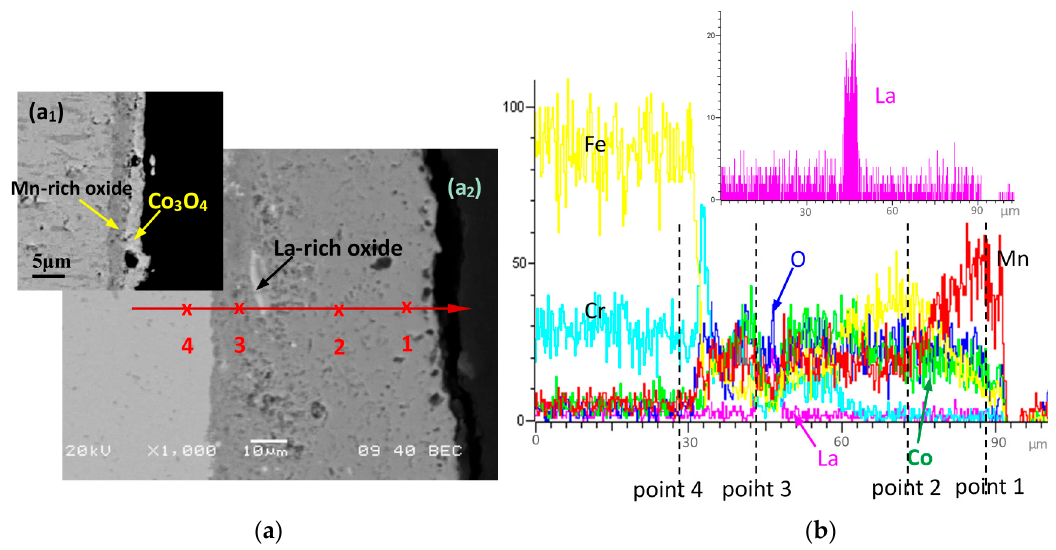
Figure 4. Cross-section morphology and EDS line scanning of Co-38Mn-2La coating oxidized at 750 °C in air for 100 h. The line scan position is shown in the cross-sectional image. ( a ) Cross section; ( b ) EDS line scanning. Table 2. Composition analysis by EDS of the local region in Figure 4.